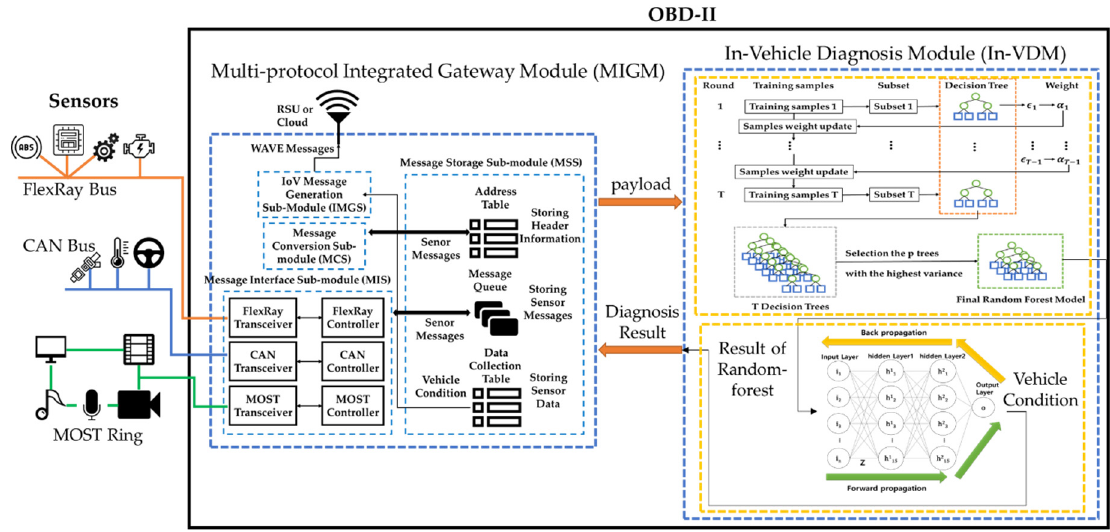
Figure 3. The structure of the lightweight autonomous vehicle self-diagnosis (LAVS).